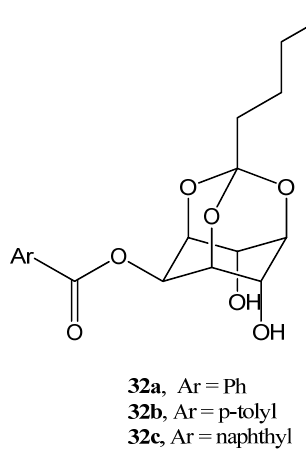
Figure 19. Illustration of the assembly mechanism and energy transfer process of 31a and Eu 3+ ions. Reprinted with permission from [84]. Copyright 2015 Royal Society of Chemistry.